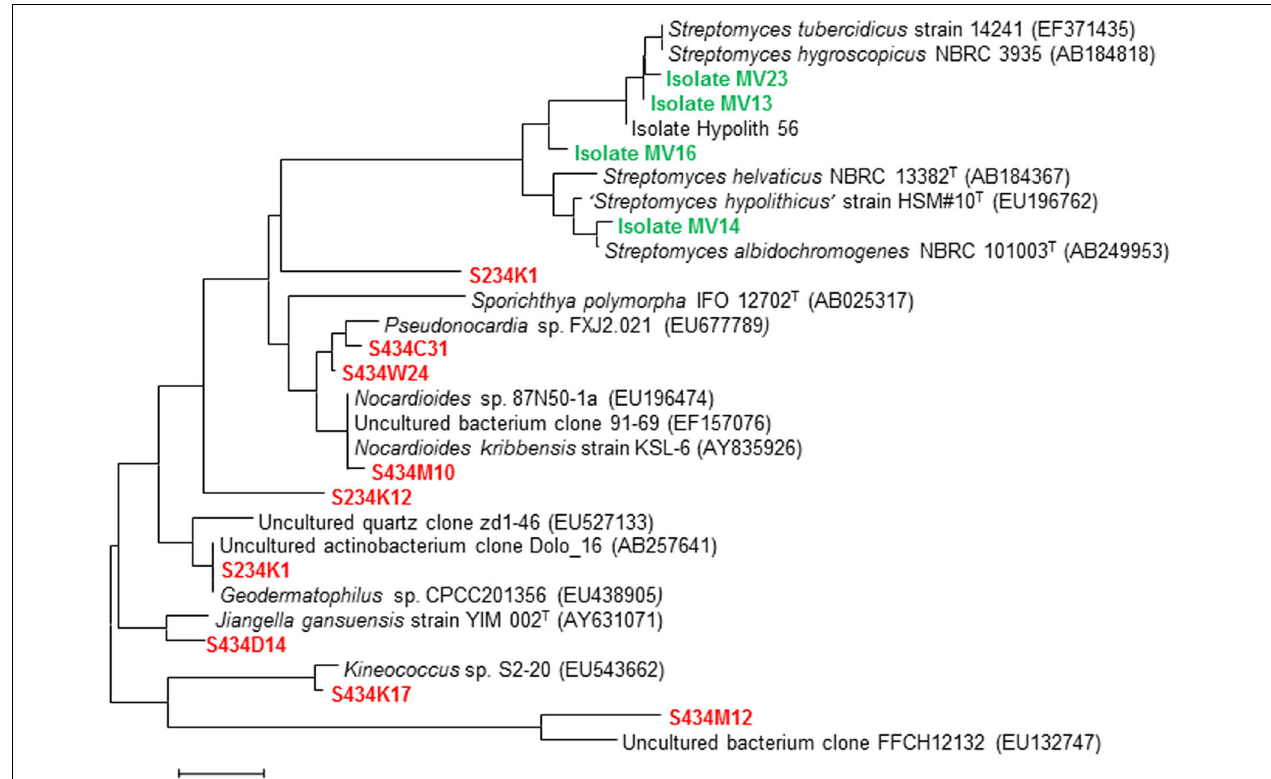
FIGURE 12 | Phylogenetic distribution of Actinobacteria in Antarctic Dry Valley soils (clones in red: redrawn from Babalola et al., 2009), indicating cultured taxa (isolate codes in green: Cowan et al., unpublished